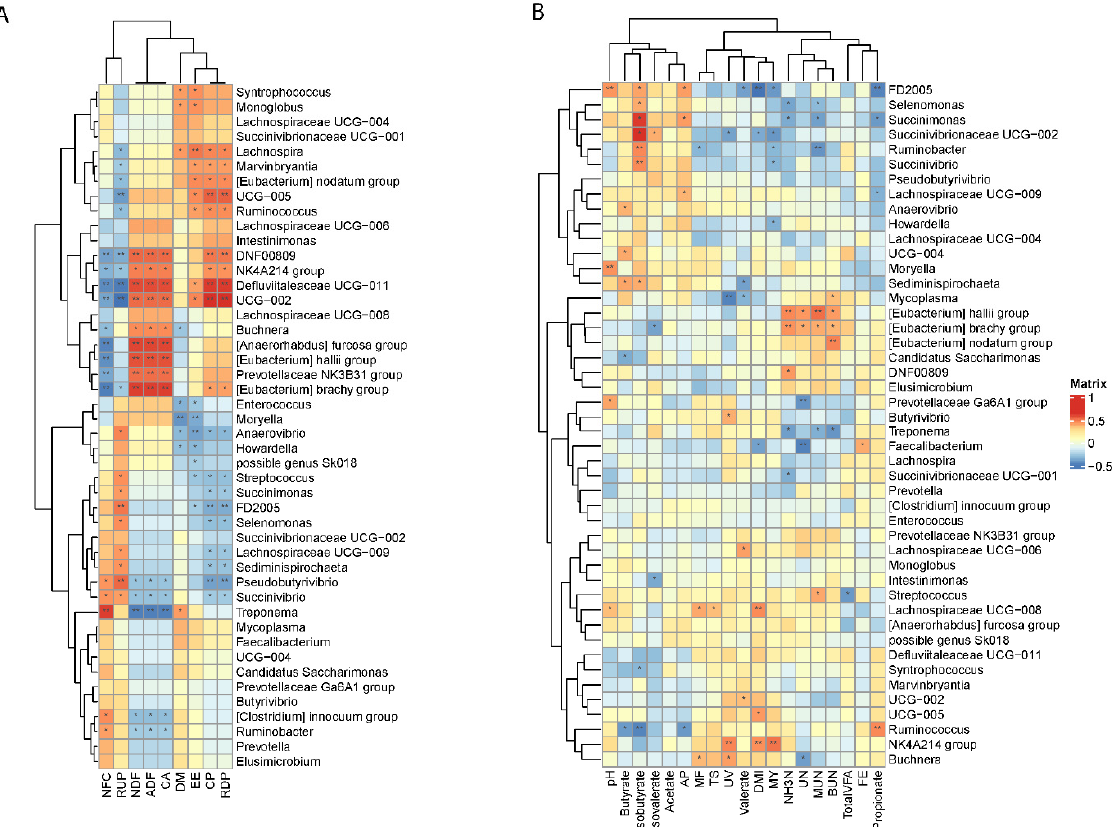
Figure 6. Spearman correlations of differentially abundant genera and ( A ) nutrient components, ( B ) physiological indexes and rumen fermentation variables. Columns represent nutrient components, physiological parameters and rumen fermentation variables, and rows correspond to the genera significantly affected by the dietary treatments. Gradient colors indicate correlation coefficients. Correlation with p ≤ 0.01 were marked with **, and 0.01 < p ≤ 0.05 were marked with *. Genera were clustered according to Euclidean distances calculated based on the correlation coefficients.